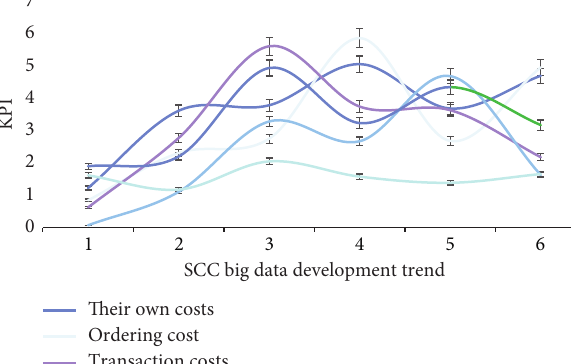
Figure 4: Cost composition chart of the procurement link.